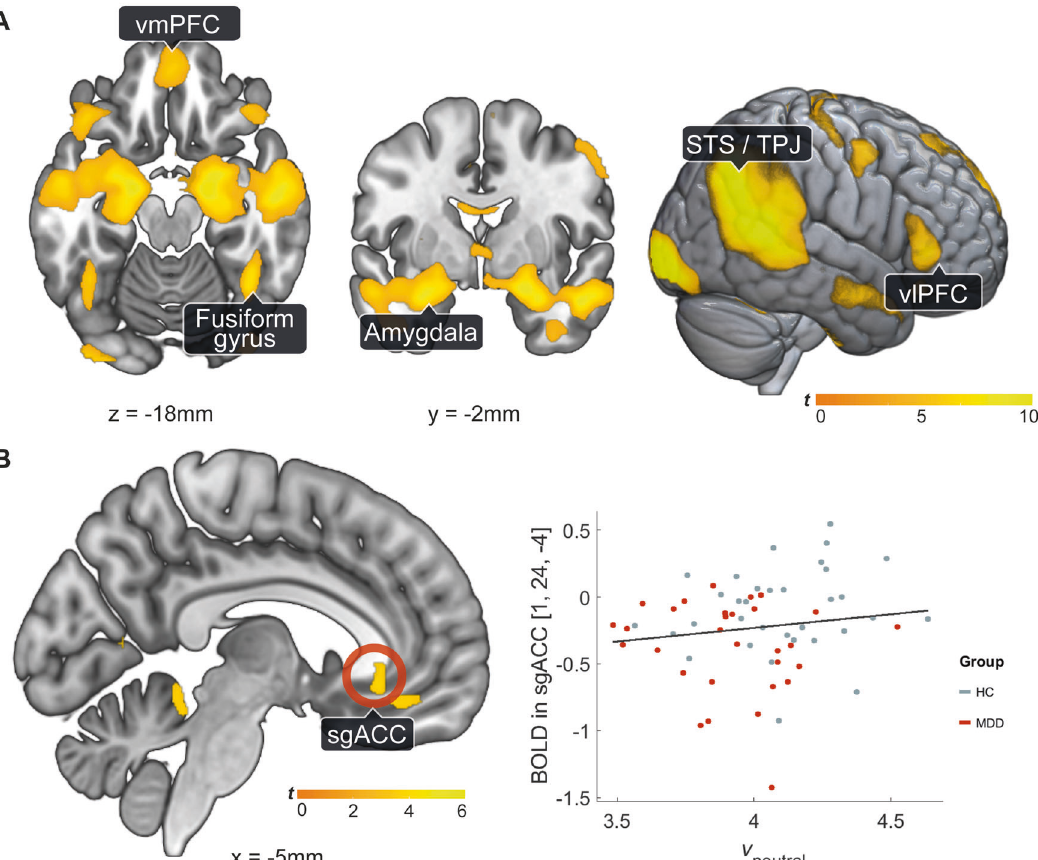
Fig. 3 Whole-brain activity analysis. A Brain activity for the task (faces-shapes) across both groups. We found activity in the amygdala, the fusiform gyrus, the ventromedial prefrontal cortex (vmPFC), ventrolateral prefrontal cortex (vlPFC), and in a cluster comprising the superior temporal sulcus (STS) and the temporo-parietal junction (TPJ). B Brain activity positively associated with the drift rate (i.e. information processing ef fi ciency) during the neutrally/ambiguous valenced dynamic face matching. We found that a slower drift rate is related to a cluster in the subgenual anterior cingulate cortex (sgACC). p FWEc < 0.05, p CDT < 0.001, N =